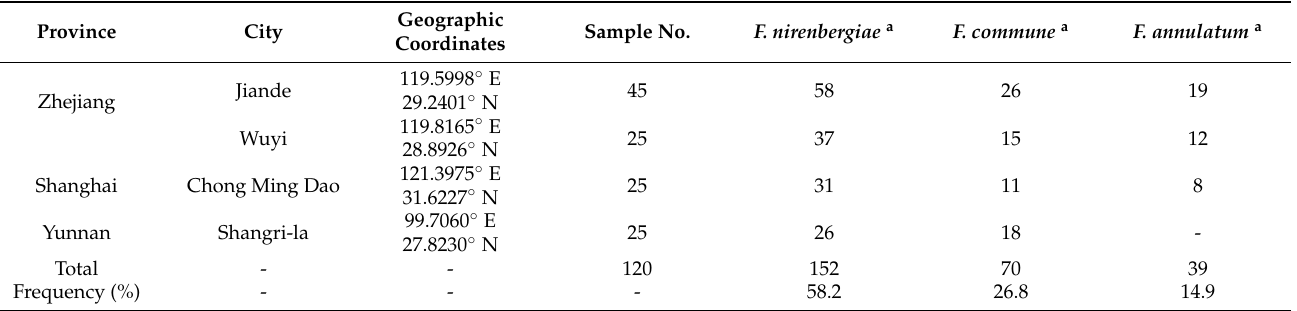
Table 1. Sampling details, isolates number, and frequency of fungal species identified in the present